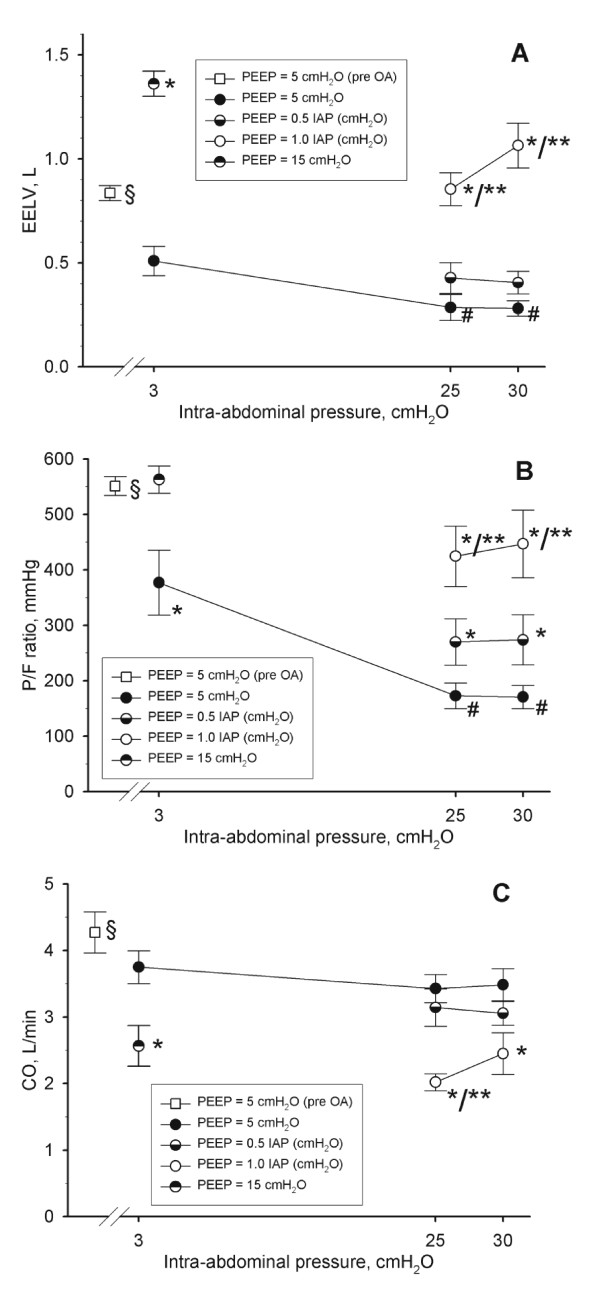
End-expiratory lung volumes in L (A), arterial oxygen tension/fractional inspiratory concentration of oxygen (P/F ratio) in mmHg (B) and cardiac output (CO) in L/minute (C) in function of different levels of intra-abdominal hypertension (IAH) (baseline (3 cmH2O), grade II IAH, (25 cmH2O = 18 mmHg), and grade III IAH (30 cmH2O = 22 mmHg)) at different degrees of IAP-matching levels of positive end-expiratory pressures (PEEP). Mean and SE are shown. ANOVA and post hoc Student-Newman-Keuls were used for statistical testing. §, P <0.05 comparing before and after oleic acid (baseline IAP and 5 cmH2O PEEP). *, P <0.05 within an IAP setting versus the corresponding value at 5 cmH2O PEEP. **, P <0.05 within an IAP setting comparing moderate versus high PEEP. #, P <0.05 within a PEEP setting versus the corresponding value at baseline IAP. ANOVA, analysis of variance.